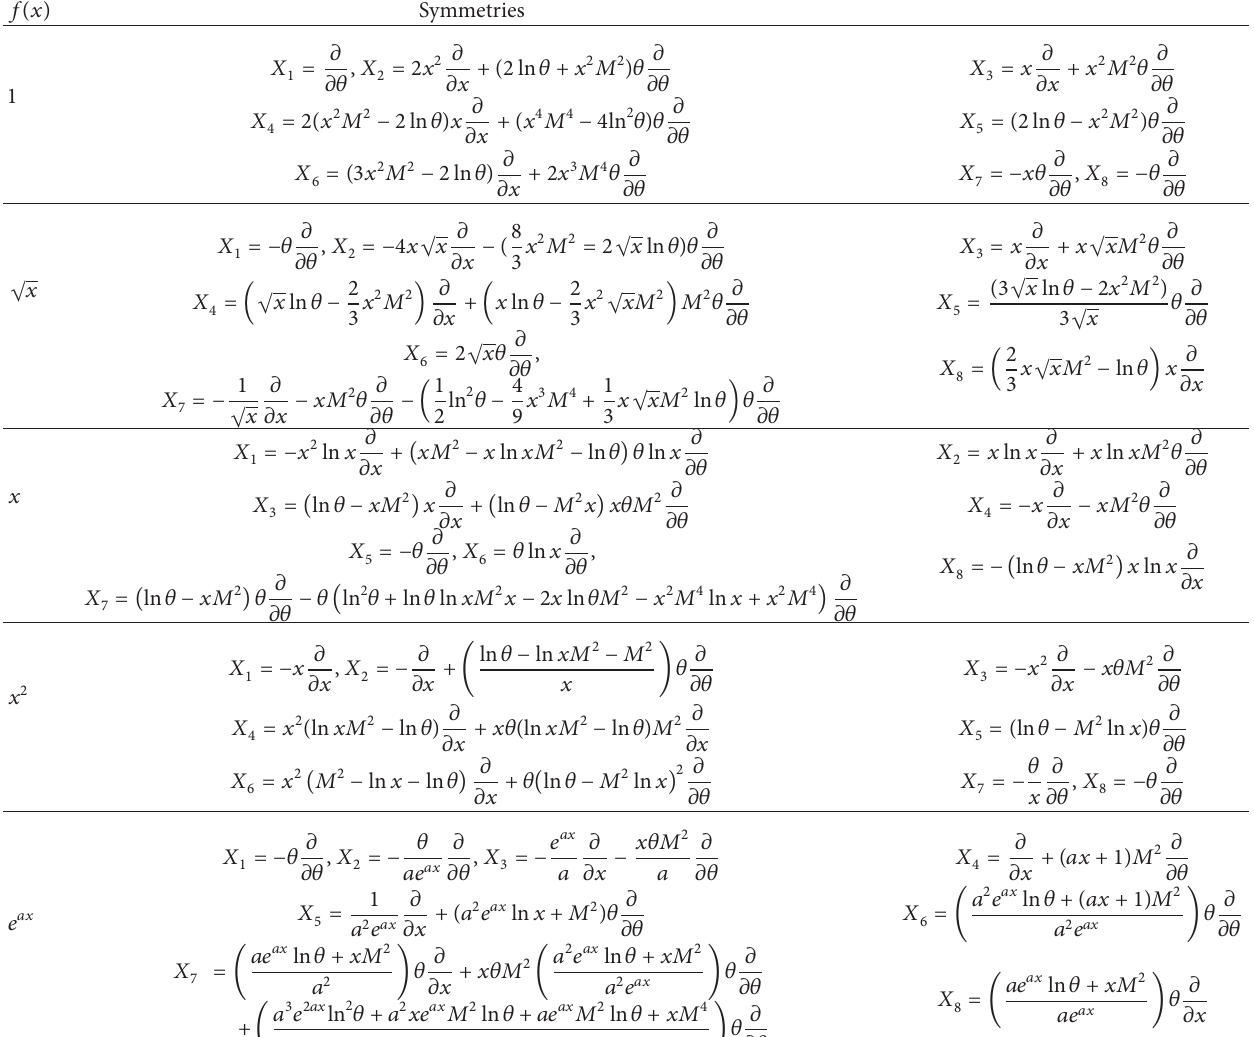
Table 7: Symmetries for 𝑚 = 𝑛 = −1,𝑓(𝑥) = 𝑥 𝑎